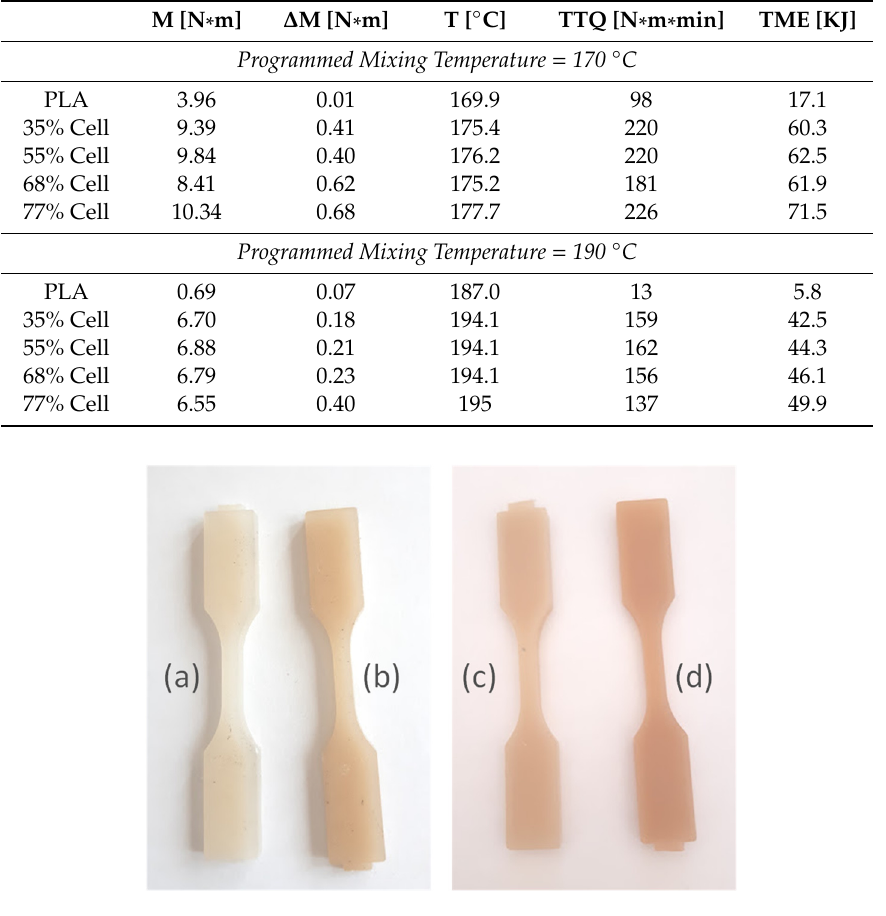
Table 2. The measured parameters after 25 min of the compounding phase of the mixtures.